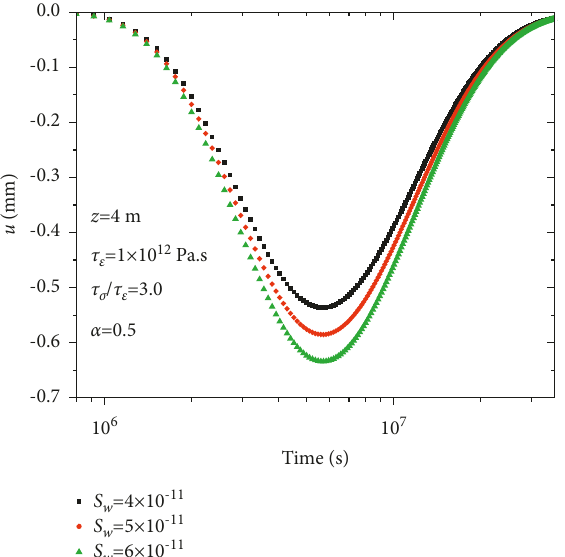
Figure 16: Influence of the phenomenological coefficient S